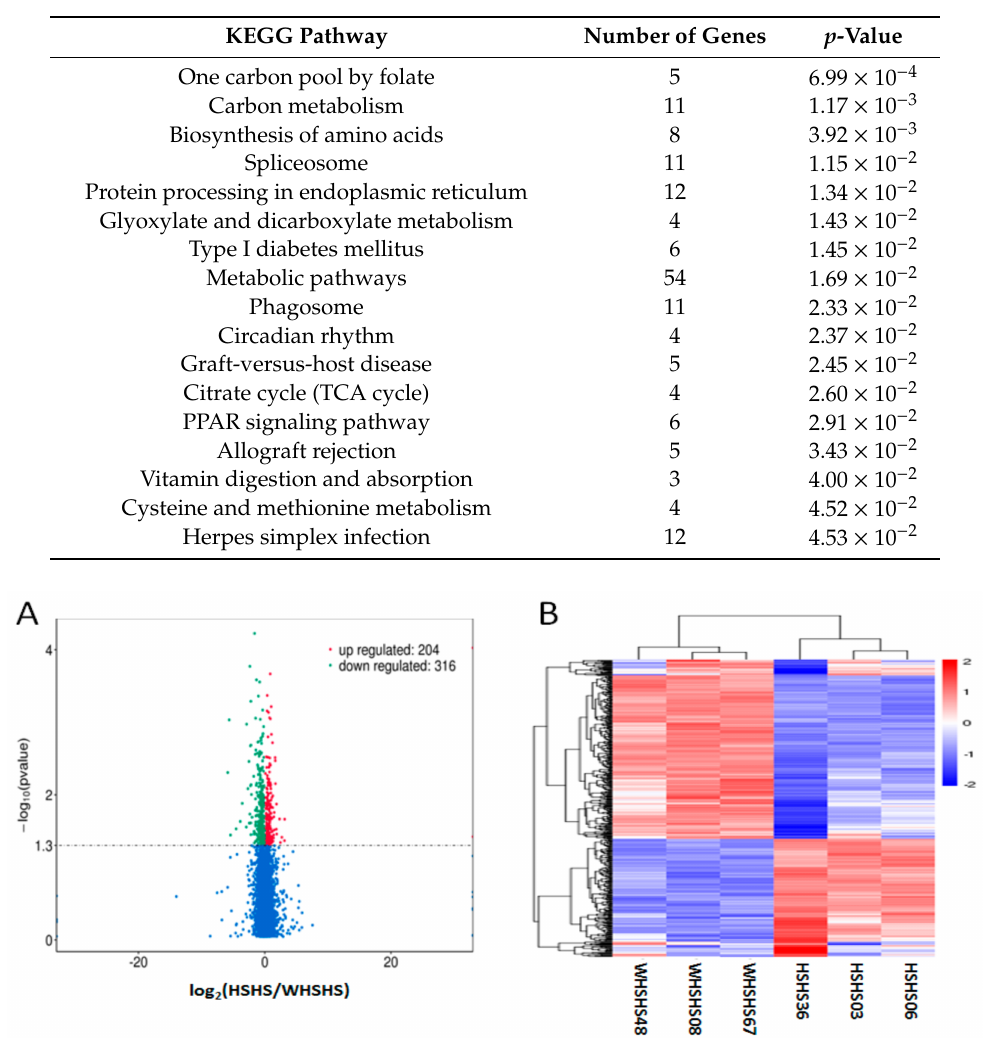
Table 4. KEGG pathway enrichment analysis of di ff erentially expressed mRNAs.